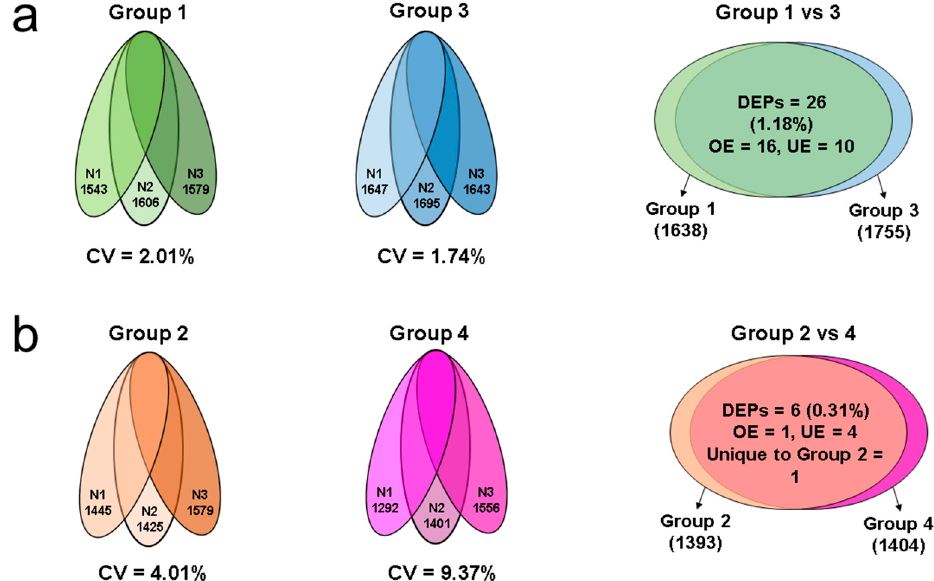
Figure 1. Comparative proteomic analysis of semen samples with round cells and leukocytes ≥ 1 × 106/mL or round cells < 1 × 10 6 /mL. ( a ) Total number of proteins detected in group 1 and group 3 run in triplicate (N1, N2, and N3), and differentially expressed proteins in group 1 vs. group 3; and (b) total number of proteins detected in group 2 and group 4 run in triplicate (N1, N2, and N3), and differentially expressed proteins in group 2 vs. group 4. Group 1 contained neat semen with round cells and leukocytes ≥ 1 × 10 6 /mL, group 2 contained neat semen with round cells ≥ 1 × 10 6 /mL that was processed by 65% density gradient to remove the round cells and leukocytes, group 3 contained neat semen with round cells < 1 × 10 6 /mL, and group 4 contained neat semen with round cells < 1 × 10 6 /mL that was processed by 65% density gradient to remove the round cells. CV: coefficient of variation, DEPs: differentially expressed proteins, OE: overexpressed, UE: underexpressed. Table 1. Differentially expressed proteins and their abundance in semen samples from group 1 ( ≥ 1 × 10 6 /mL leukocytes) and group 3 (round cells < 1 × 10 6 /mL). Uniprot Gene Protein No. Name